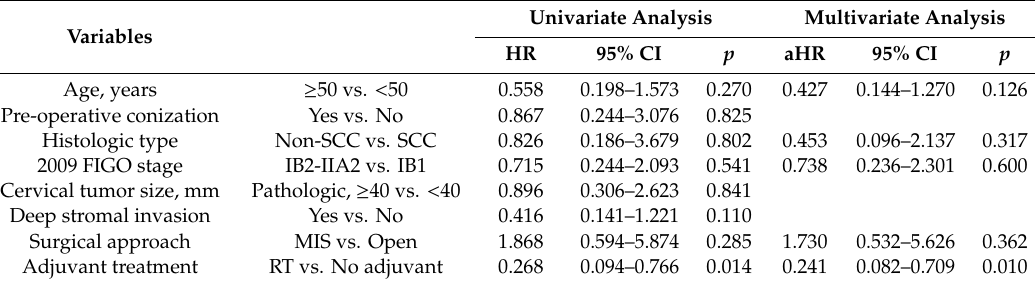
Table 2. Factors associated with recurrence-free survival.